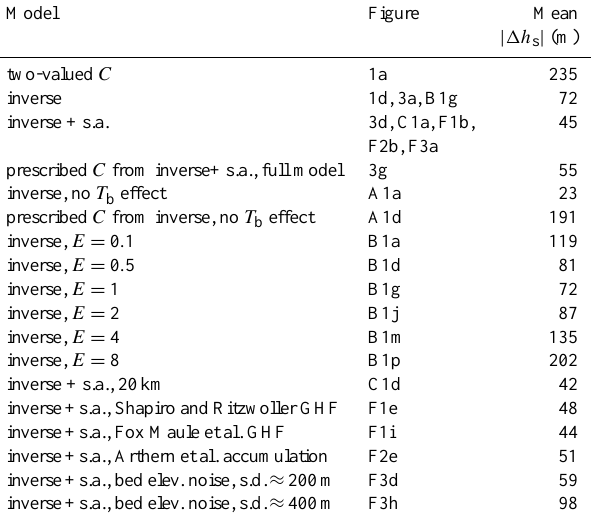
Table 1. Mean absolute surface elevation error (model minus ob- served | 1h s | , m) for nearly all simulations in the paper. Averages are taken over grounded ice.